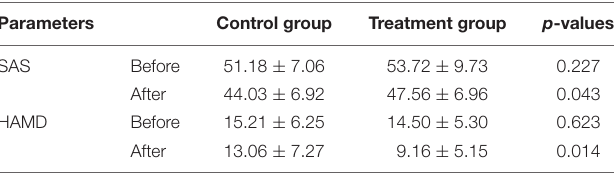
TABLE 6 | The comparison of the scores of anxiety and depression between two groups.